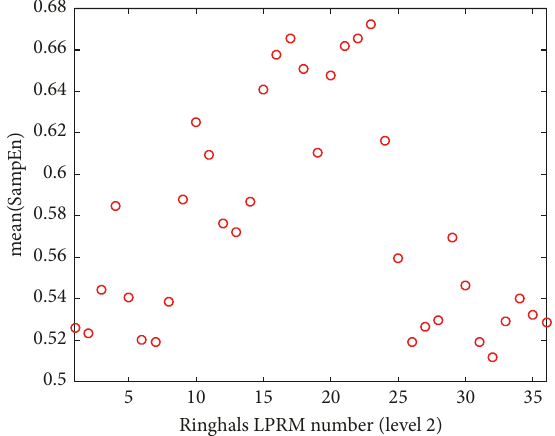
Figure 30: Mean(SampEn) values for the 36 LPRMs of level 2 of the Ringhals BWR